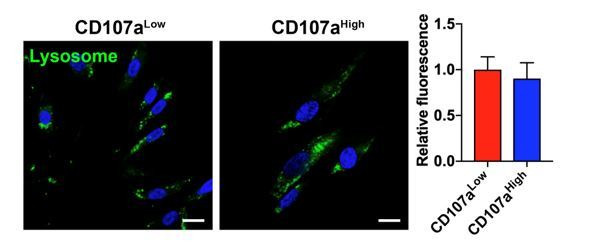
No change in lysosome immunohistochemical staining among human CD107alow and CD107ahigh cells.Lysosome positive staining appears green. White scale bar: 20 μm.